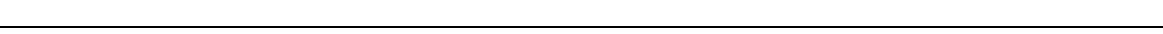
Fig. 4 WGCN analysis identi fi es Prkag2 in a central hub of pacemaker regulating genes. a Weighted gene co-expression network (WGCN) analysis-derived visualization of the iSAB – aCaB gene network by heat map plot. The heat map shows the topological overlap matrix (TOM) among all genes in the analysis. Light yellow represents low overlap and darker red represents higher overlap. Blocks along the diagonal are modules. Dendrograms and module color assignments are shown at the top and along the left side, respectively. b Re fi nement of the gene modules showing the gene dendrogram (average linkage) and module color assignment based on dynamic hybrid TOM clustering. c Plot of gene signi fi cance and intra-modular connectivity illustrating high correlation within the green module containing Prkag2 . d Plot of co-expressed genes in the green module vs gene signi fi cance subdividing iSABs and aCaBs. e Further investigation of the relationship and connectivity among the investigated modules illustrated by (upper portion) a hierarchical clustering dendrogram (average linkage) and (lower portion) eigenvalue adjacency heatmap. f Multi-dimensional scaling plot identifying the green module as a major signaling hub connecting multiple genes critical to pacemaker functionality. g Heat map illustrating the TOM among genes depicted in e . Each column and row refers to a single gene. Light yellow represents low overlap and darker red represents higher